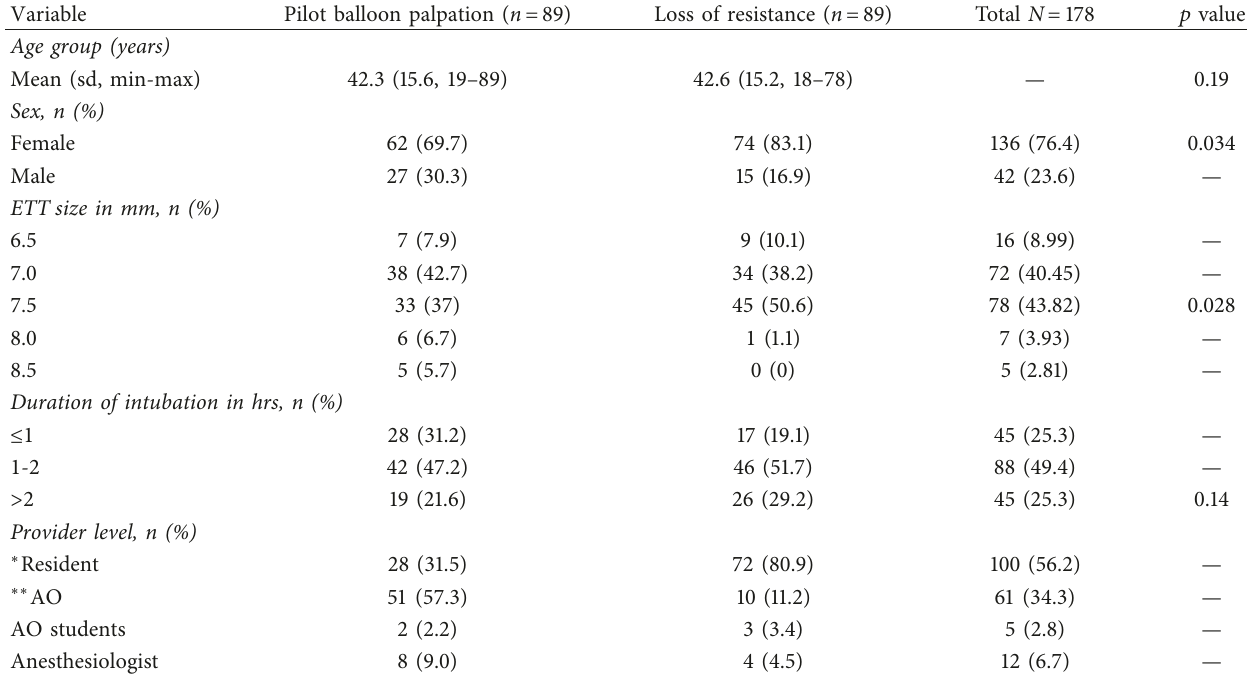
Table 1: Baseline characteristics of patients.